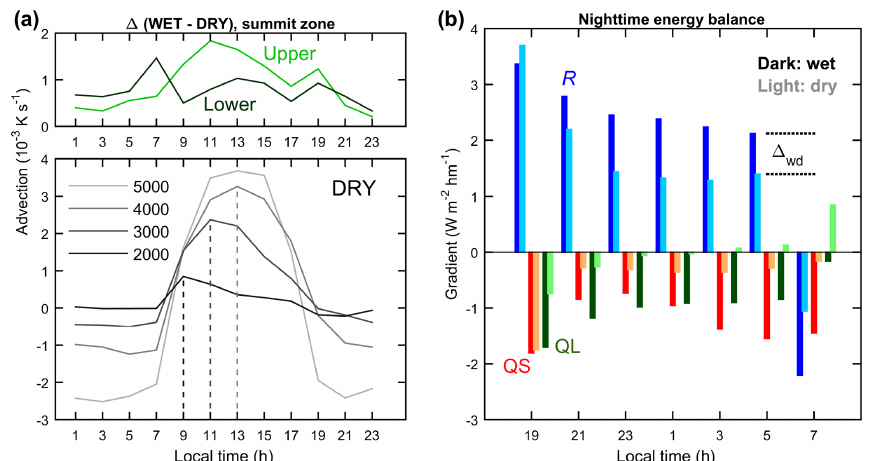
Figure 7. (a) Mean diurnal cycle of potential temperature advection near the surface of the southern slope (bottom) in the dry season for different elevation bands ( ± 100m from the given center altitude; vertical lines indicate the maxima between 2000 and 4000m) and (top) of the related differences in the wet season for the upper ( > 5716m) and lower (5500–5600m) summit zone. (b) Mean elevation gradients in the climatological dry (JF, JJAS) and wet (MAM, OND) seasons in light and dark tones, respectively, for the summit zone in the course of the night: sensible (QS) and latent (QL) turbulent heat flux and net radiation ( R ). The gradient difference between wet and dry season ( (cid:49) wd ; discussed in Sect. 3.2.3) is exemplified for R at 05:00LT. Plots are based on the atmospheric model output for the period 8 October 2009 to 30 September